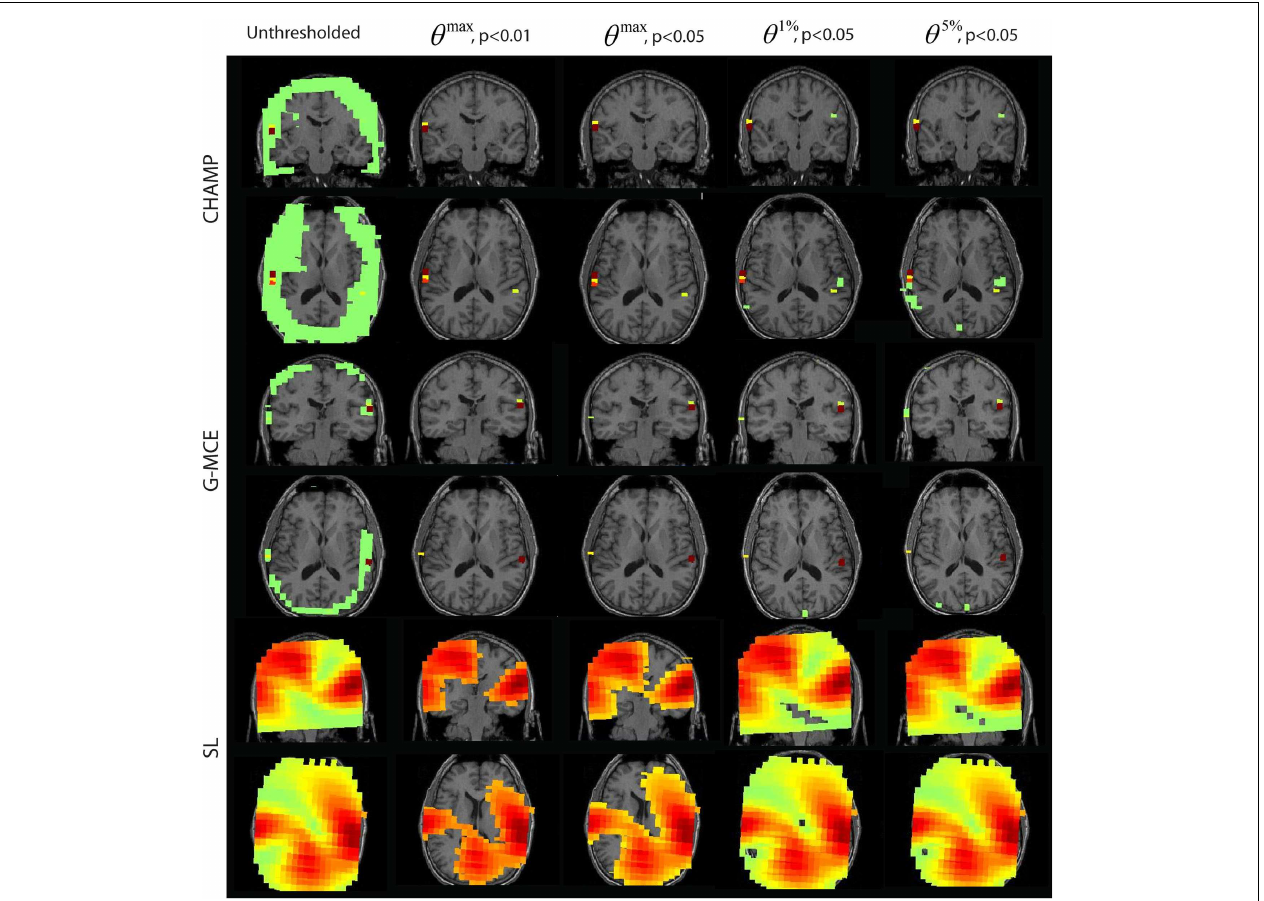
the first column (coronal slice).The power is thresholded with the maximal statistic: θ max , p < 0.01 and 0.05 and with the alternative to the maximal statistic thresholds: θ 1% , p < 0.05, and θ 5% , p < 0.05.